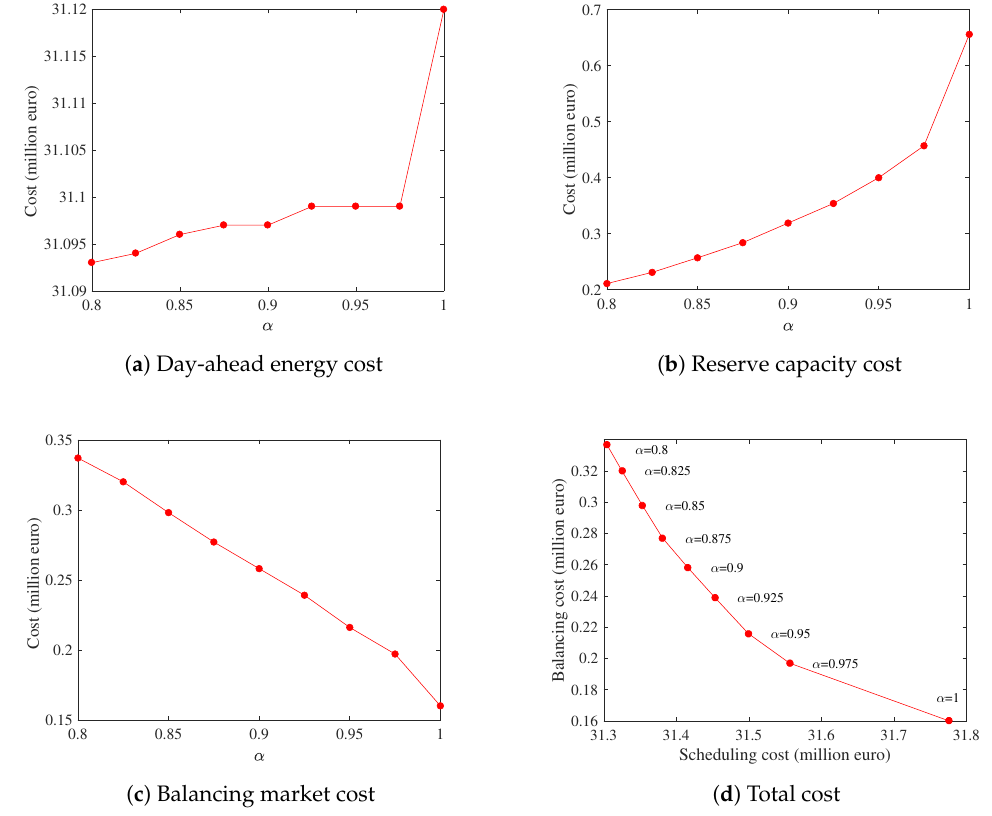
Figure 7. Total cost with respect to α